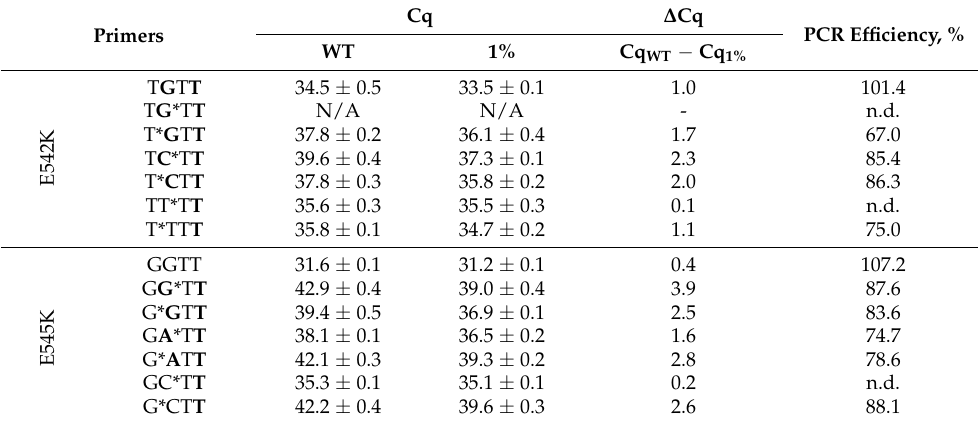
Table 3. AS-PCR PIK3CA mutation detection using WT DNA (total 10 4 copies per reaction) and 1% mutant DNA on the background of WT DNA.